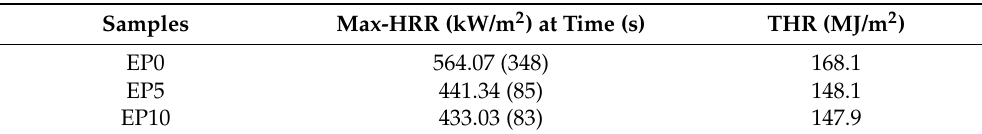
Table 3. Cone calorimeter data of EP series.